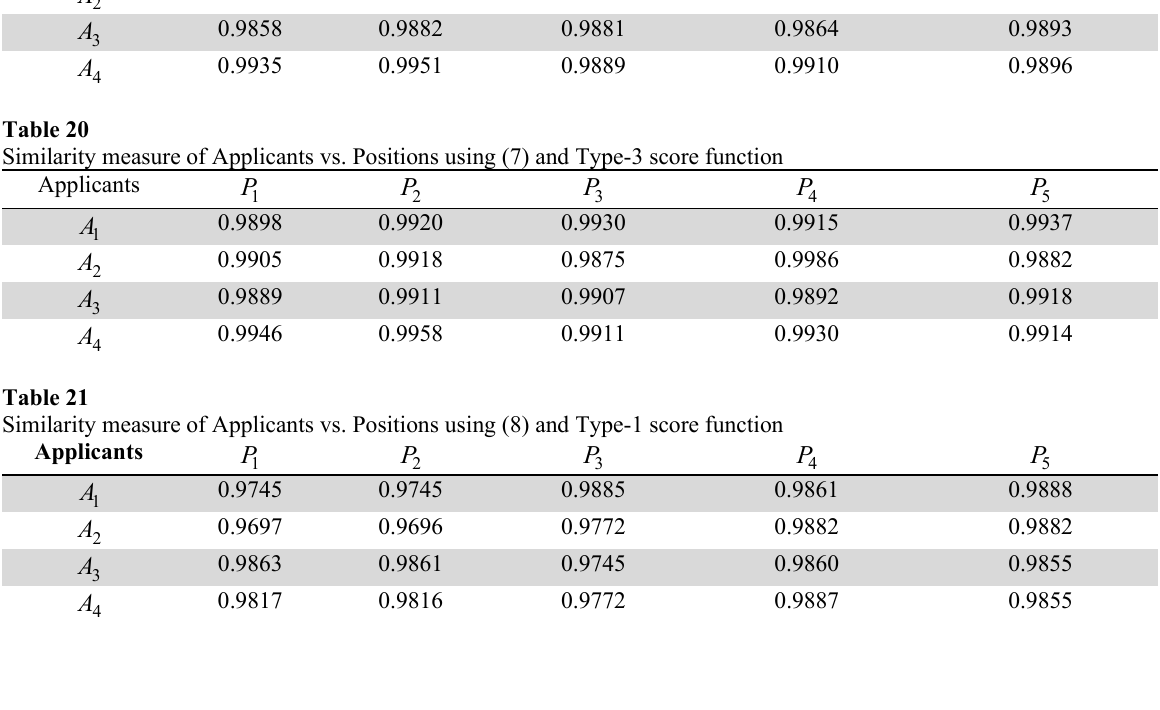
Similarity measure of Applicants vs. Positions using (8) and Type-2 score